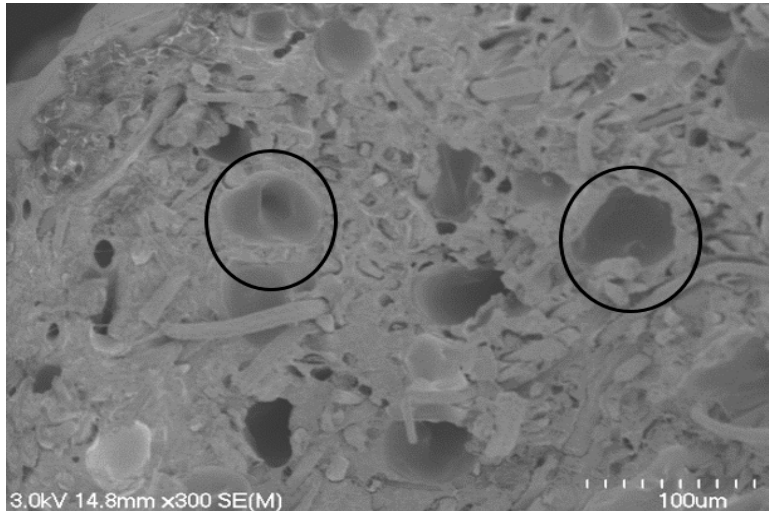
Figure 7. 20 wt % harakeke 3-mm filament cross-section.